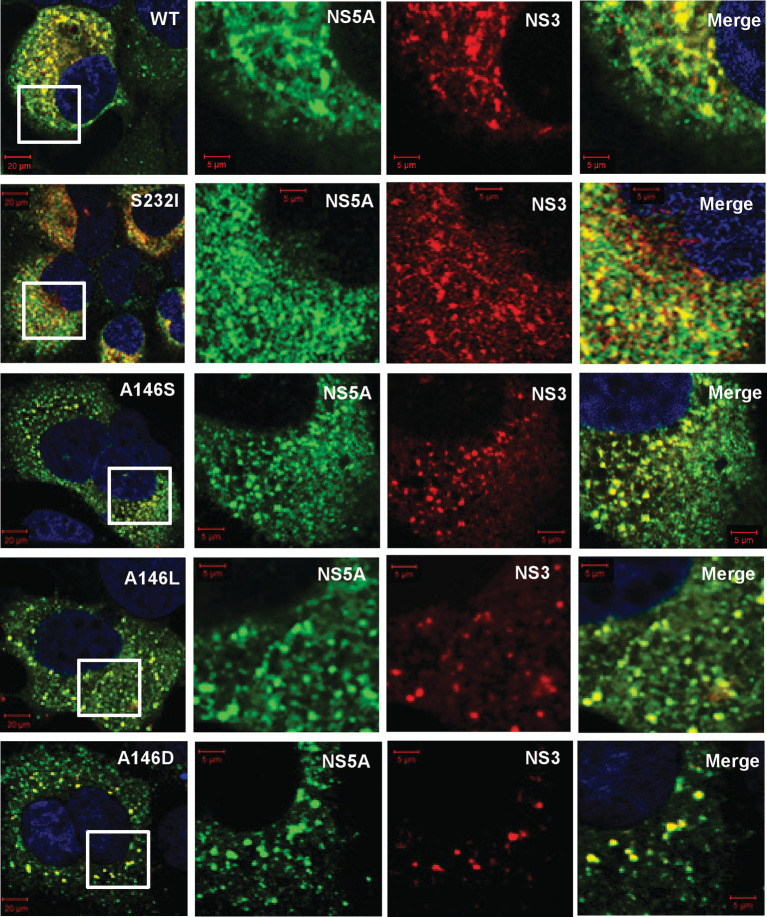
Colocalization of NS5A and NS3. Huh7 cells were electroporated with in vitro transcripts of the indicated SGRs, and seeded onto coverslips. At 48 h p.e. cells were fixed and immunostained for NS5A and NS3 (mouse monoclonal anti-NS3), prior to imaging by confocal microscopy. White boxes indicate the area expanded in the right-hand panels.